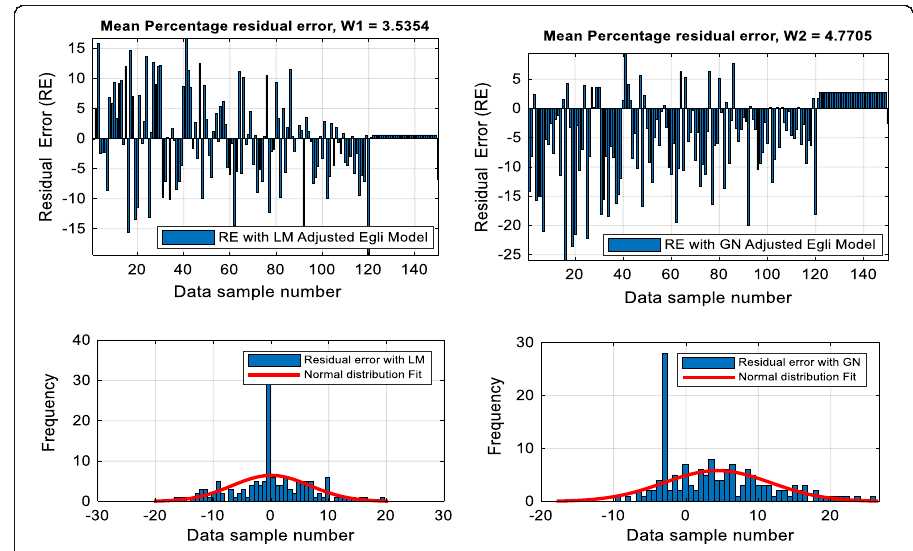
Fig. 8 Measured propagation loss estimation and their error distribution statistics using classical Egli model and adapted Egli model for Cell_1